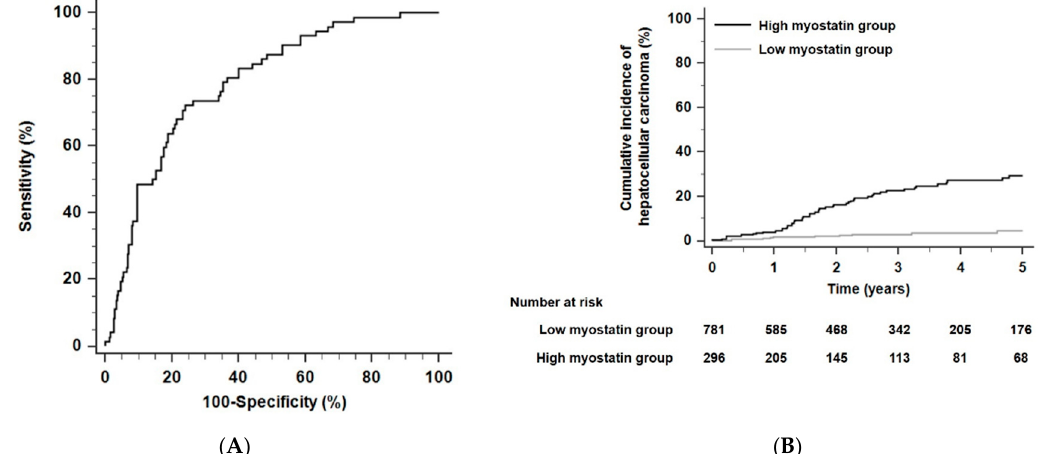
Figure 1. The predictive performance of serum myostatin levels and the cumulative probability of HCC in alcoholic liver cirrhosis (ALC) patients. ( A ) Time-dependent areas under receiver operating characteristic curves (AUROCs) of serum myostatin to predict HCC development within five years. ( B ) Risk stratification for HCC development in ALC patients according to serum myostatin levels ( p < 0.001 by log-rank test). Abbreviations: ALC, alcoholic liver cirrhosis; AUROC, area under the receiver operating characteristic curve; HCC, hepatocellular carcinoma. Table 2. Cox proportional hazards regression analysis for HCC development in total population (n = 1077).